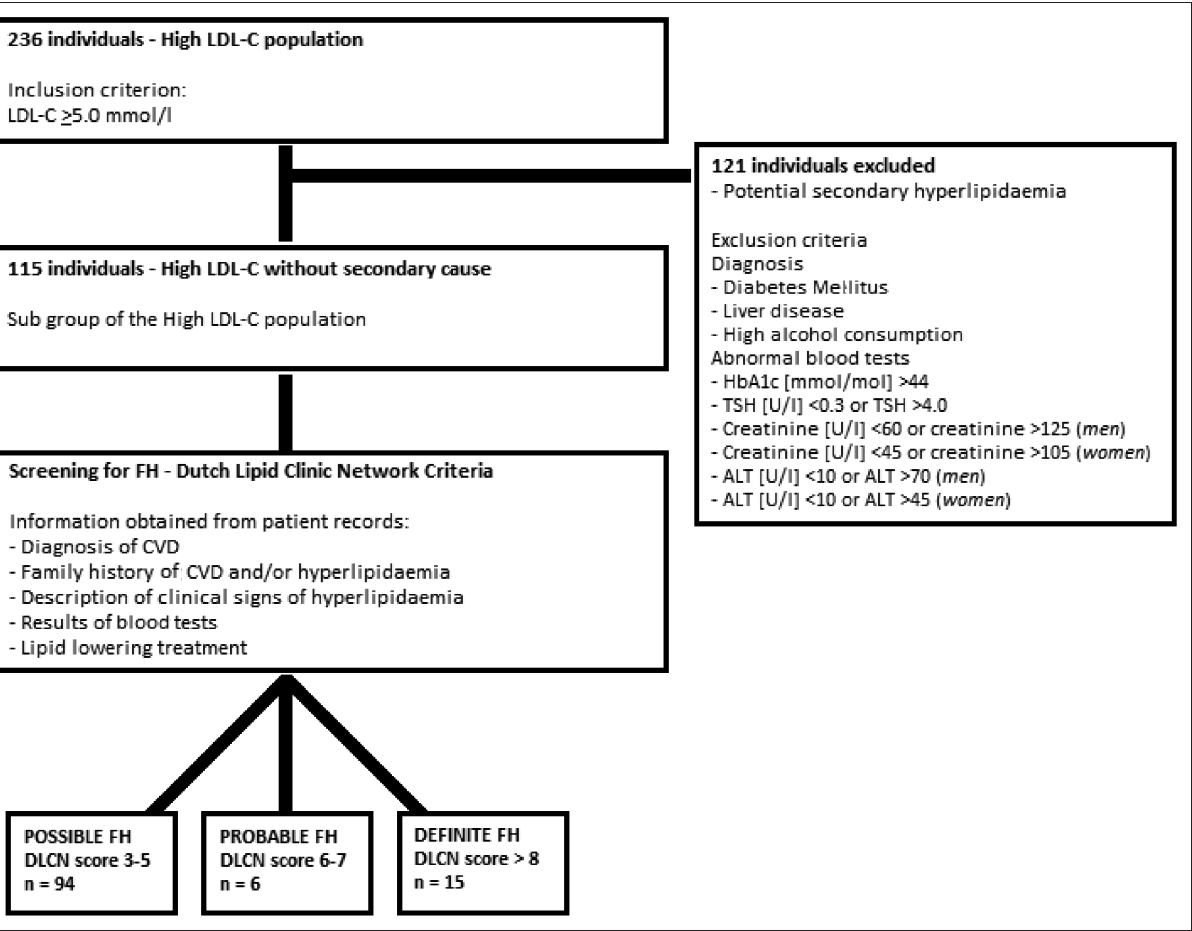
Figure 2 Flowchart of the analysis of the subgroup of individuals deemed to have primary hypercholesterolaemia. The high LDL- C population is defined as individuals with a reported LDL- C ≥5.0 mmol/l ( Figure 1 ). ALT = alanine aminotransferase. CVD = cardiovascular disease. DLCN = Dutch Lipid Clinic Network. FH = familial hypercholesterolaemia. LDL- C = Low- density lipoprotein cholesterol. TSH = thyroid stimulating